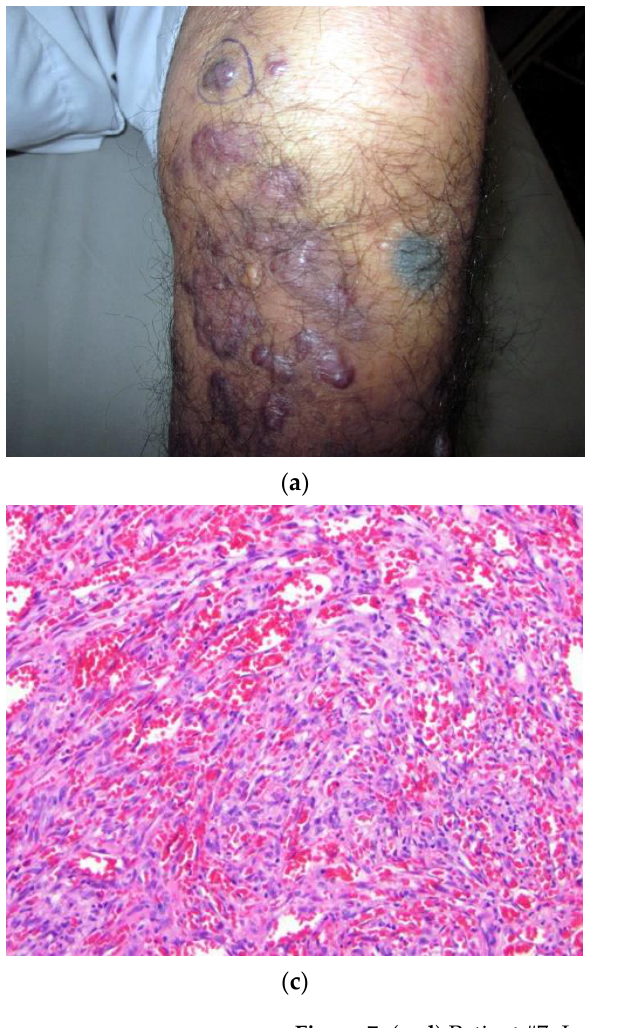
Figure 7. ( a – d ) Patient #7. Image ( a ) Lower leg with multiple, confluent violaceous nodules. Area of blue pigmentation/cutaneous discoloration represents tattoo ink. Biopsy site shown. Image ( b ) H&E 40×. Nodular proliferation within the superficial and deep dermis. Image ( c ) H&E 200×. Vascular proliferation with flattened epithelium and extravasated RBCs. Image ( d ) IHC HHV-8 200×. Scattered nuclear staining of spindled cells within the dermis.